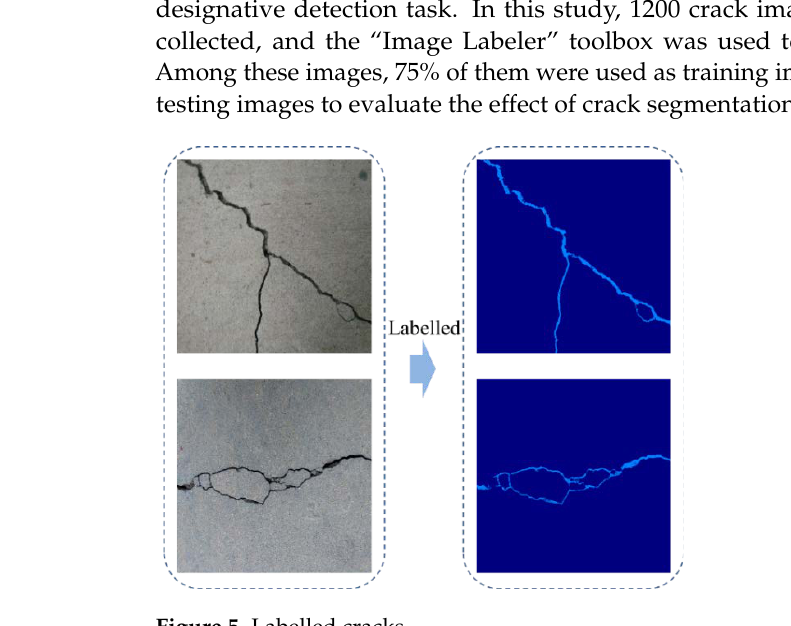
Figure 5. Labelled cracks.